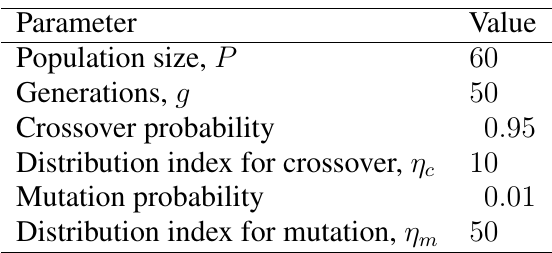
Table 1: NSGA2 parameter settings used